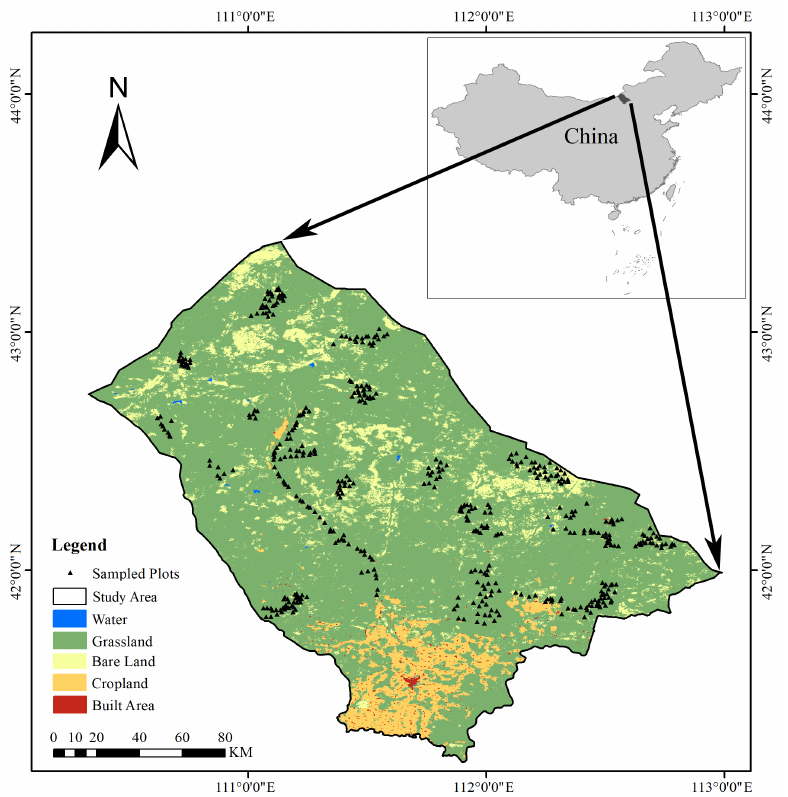
Figure 1. Land cover of Siziwang and samples distribution